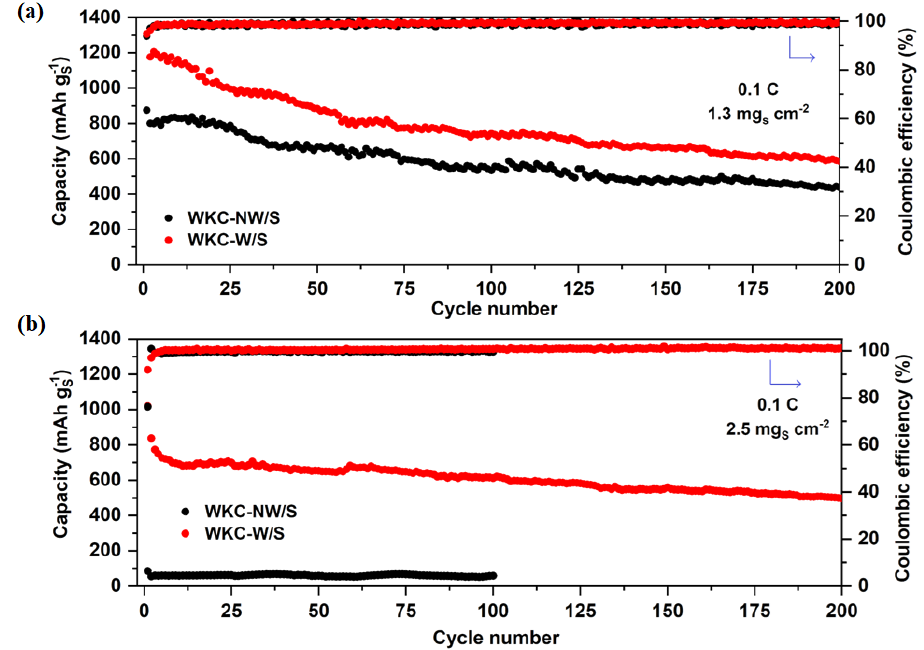
Figure 11. Long term cycling performances at 0.1 C at mass loading values of 1.3 mg S cm − 2 ( a ) and 2.5 mg S cm − 2 ( b ) obtained for WKC-NW/S and WKC-W/S